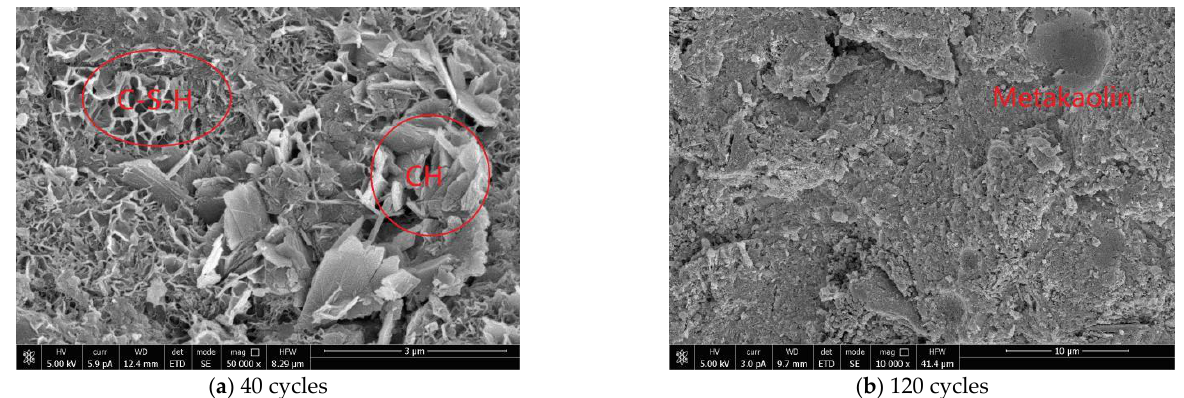
Figure 17. Microscopic morphology of MK concrete in clear water solution.